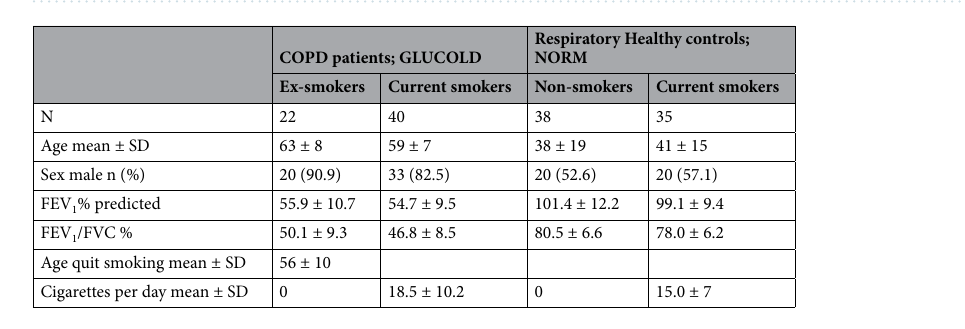
Table 1. Patient demographics in relation to smoking status. FEV 1 forced expiratory volume in 1 s, FVC forced vital